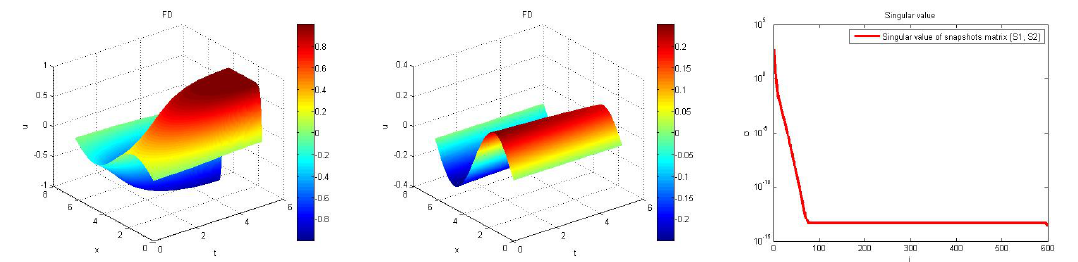
Figure 4. [Test 2] Solution of the full discretized system with (cid:101) = 0.01. The last plot shows the singular values of the snapshot matrix [ S 1 , S 2 ] from SVD using POD basis.